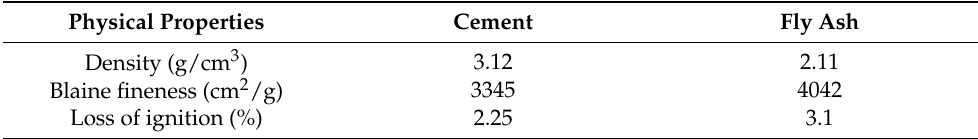
Table 2. Physical properties of hardening accelerator.